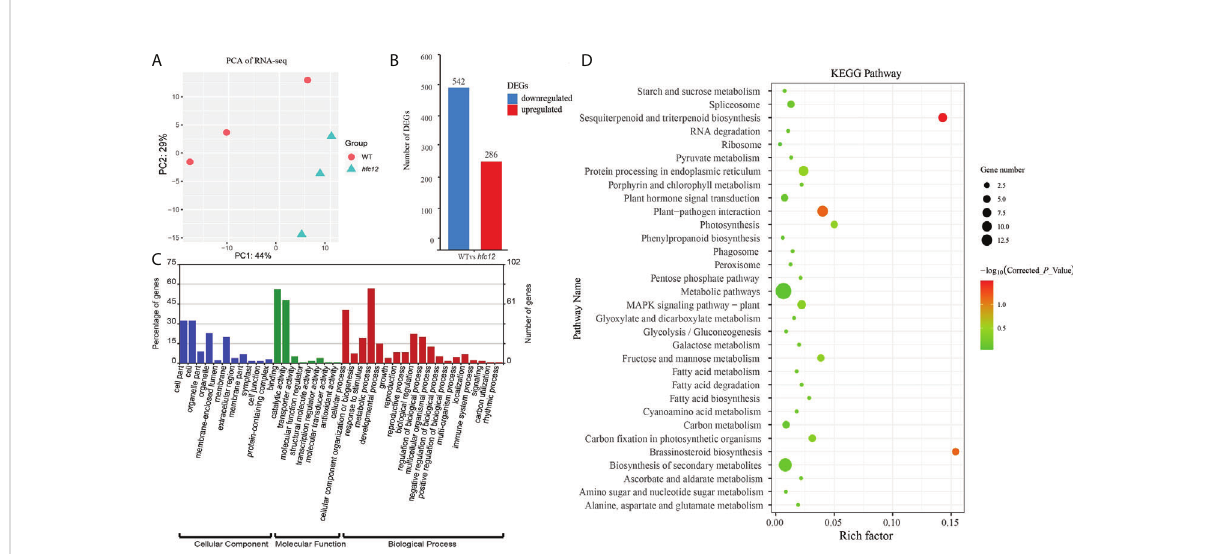
FIGURE 2 RNA-seq transcriptome analysis of WT and hfc12 . (A) PCA plot of DEGs between ‘ BWT ’ and hfc12 . (B) Differentially expressed genes (DEGs) at 40 DAP of WT and hfc12 . (C) GO enrichment analysis of DEGs. Blue bars for cellular component, green bars for molecular function, and red bars for biological process. (D) KEGG analysis of